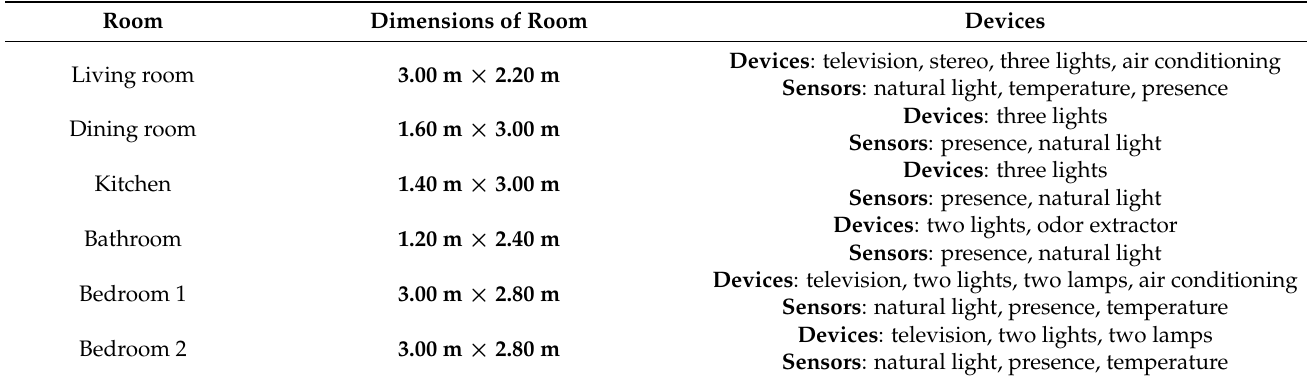
Table 1. Device distribution of the house.